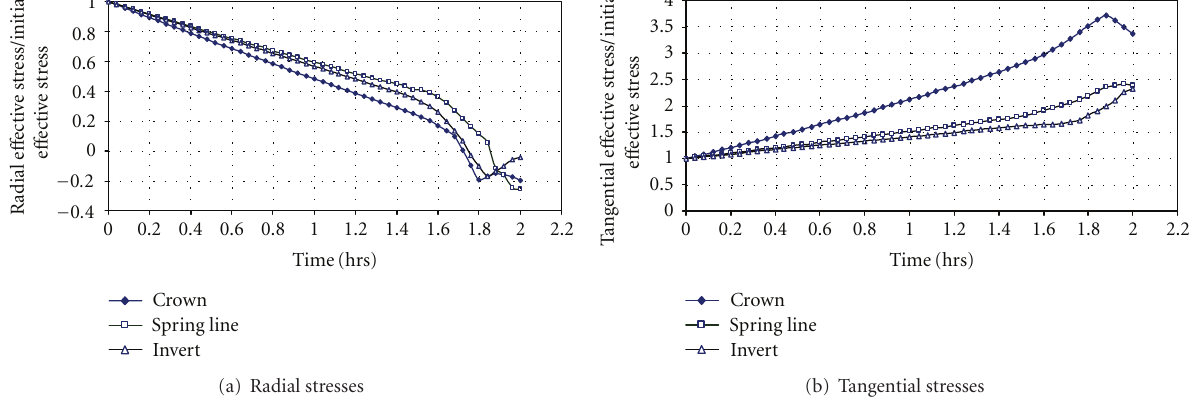
Figure 10: Variation of stresses around the tunnel at the end of excavation.